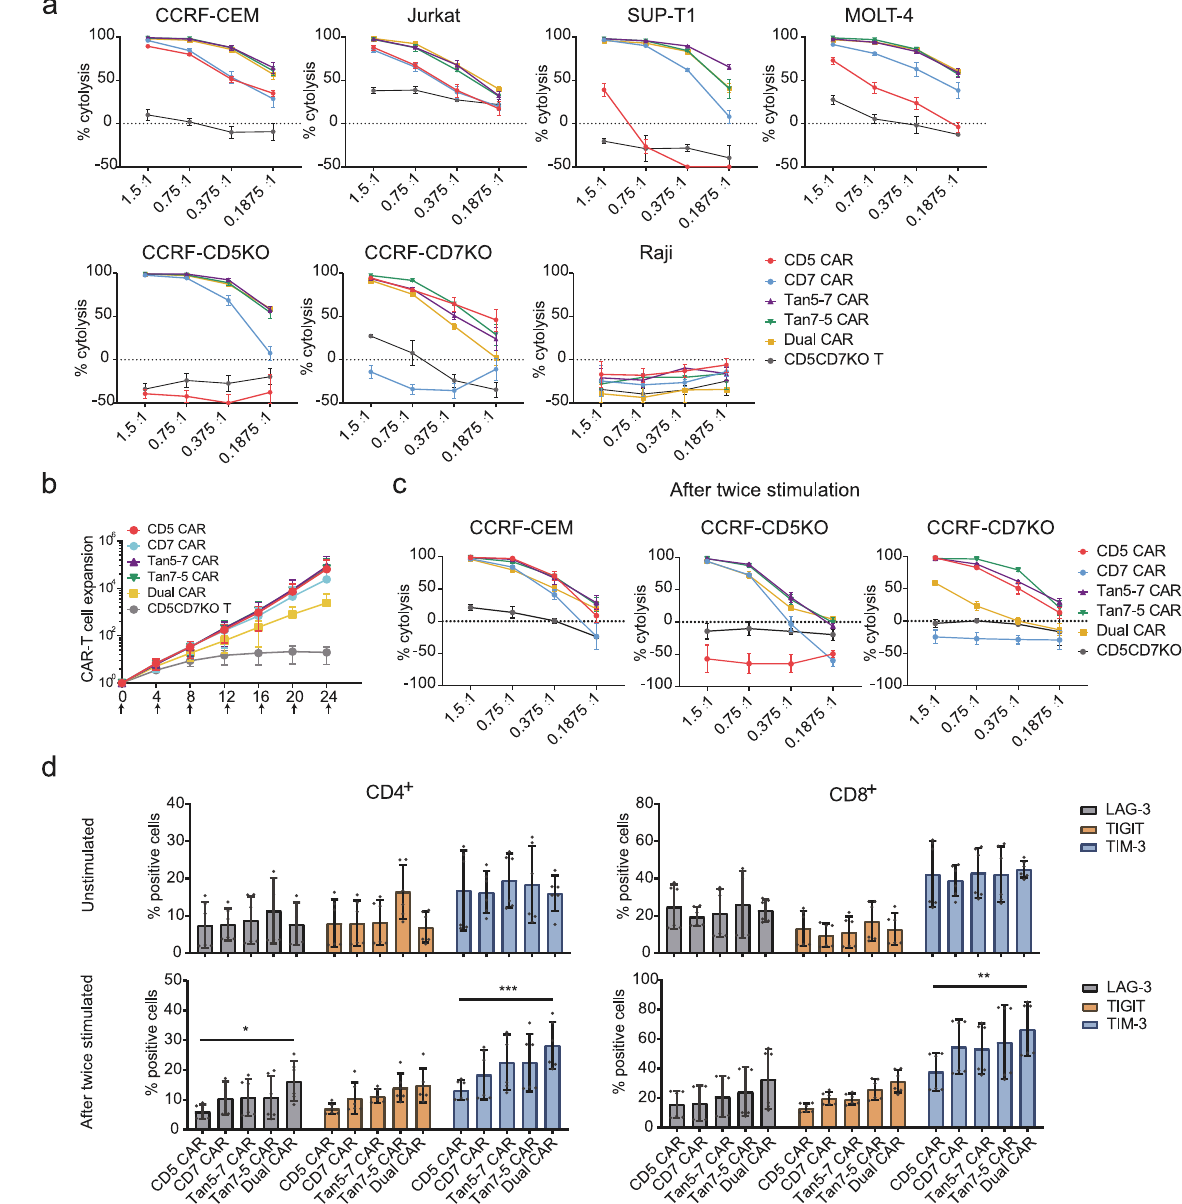
Fig. 4 Functional comparison of CD5/CD7 bispeci fi c CAR-T cells was performed in vitro. a CD5/CD7 bispeci fi c CAR-T cells speci fi cally kill CD5 + and/or CD7 + tumor cells. The data indicate mean ± SD (three replicates). b Expansion of indicated CAR-T and T cells during multi-rounds of tumor cells stimulation. The data represent mean ± SD from three donors. The X-axis represents different coculture time points of CAR-T/ T cells with CCRF-CEM cells and the arrows mean mitomycin C-treated CCRF-CEM cells were added at indicated time. c Cytolysis assay of CAR- T/T cells after two rounds of stimulation by mitomycin C-treated CCRF-CEM cells. CAR-T/T cells were remixed with tumor cells at indicated ratios (CAR + % to tumor cells) to evaluate the cytotoxicity by luciferase-based assay. The data represent mean ± SD ( n = 3). d CAR-T cells were stained with antibodies against LAG-3, TIGIT, and TIM-3, respectively, before and after two stimulations by mitomycin C-treated CCRF-CEM. The results are displayed as mean ± SD ( n = 3). * p < 0.05, ** p < 0.01, *** p < 0.001, two-way ANOVA